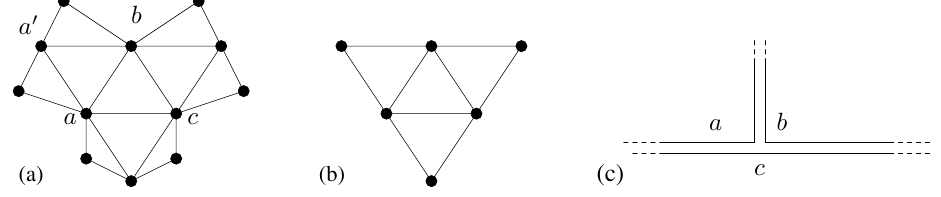
Fig. 4: (a) An outer-planar graph that is not a 1-bend EPG graph. (b) The 3-sun. (c) A